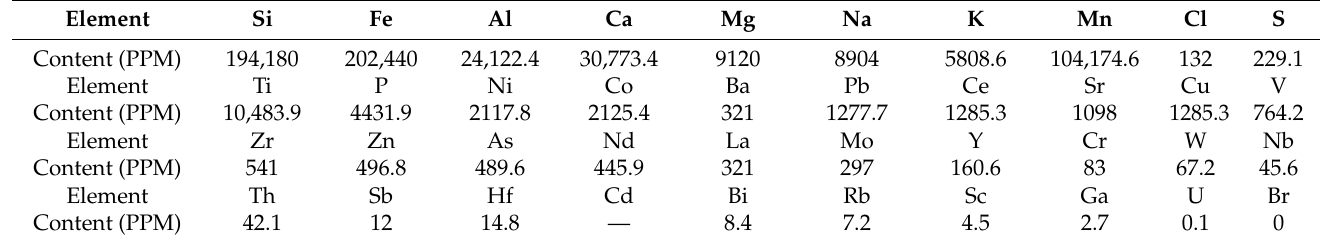
Table 1. Elemental composition of the crust powder.